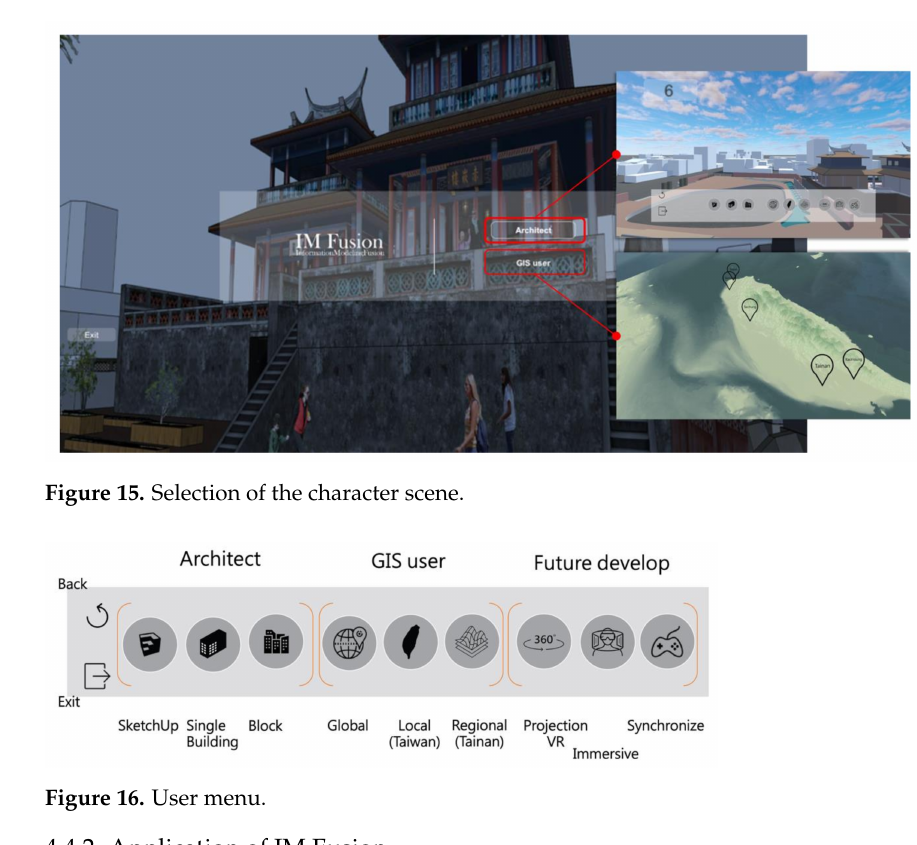
Figure 14. User interface.